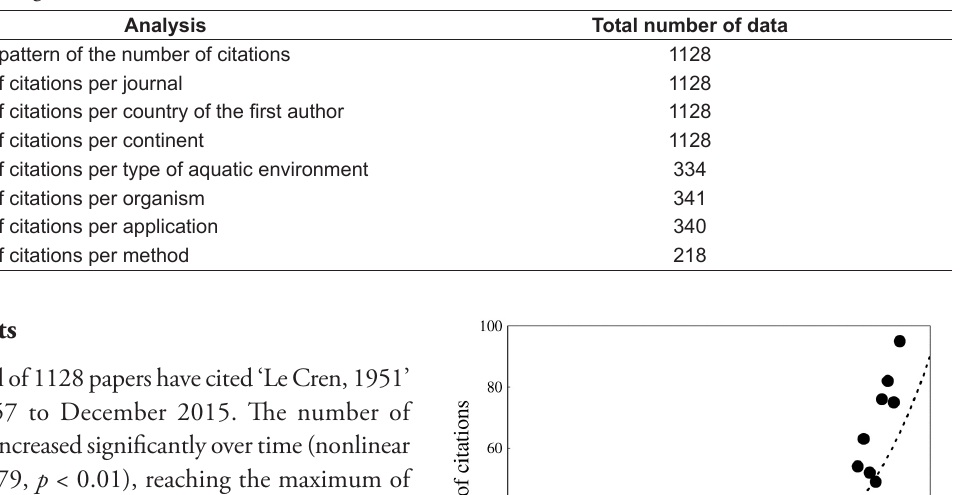
Table 2. Total amount of data recorded in each analysis based on a scientometric analysis of Le Cren’s paper published in 1951 through December 2015.